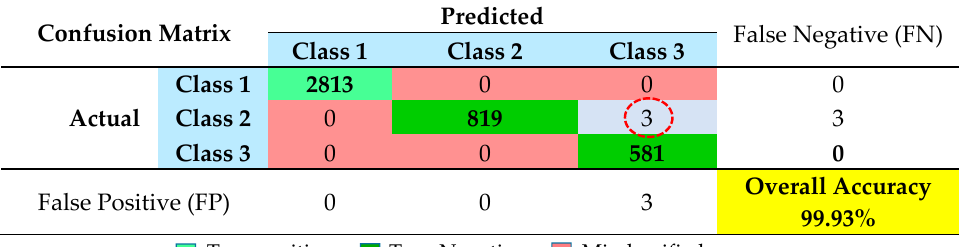
Table 7. Confusion matrix results on the test dataset. An overall accuracy is shown in the bottom right. Misclassified cases are pointed with red circle.